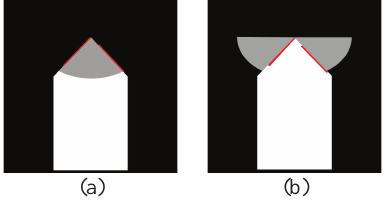
Figure 3: An illustration of two mask regions for ship validation: (a) the sector mask region M S ; (b) the semi-circle mask region M C